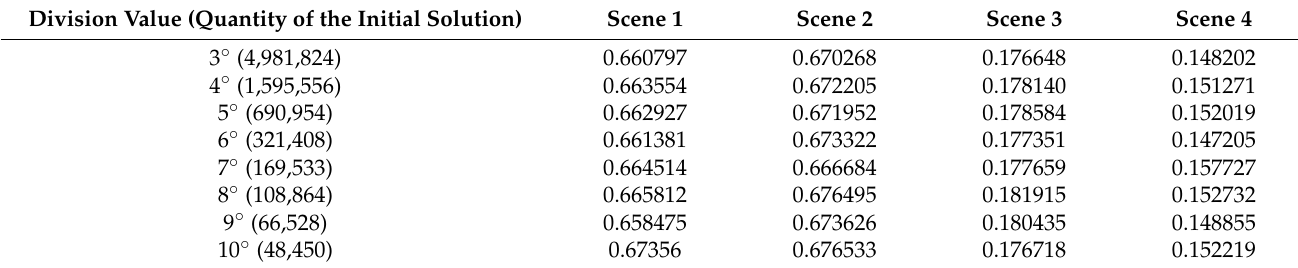
Table 8. DOR (dimensionless) of Each